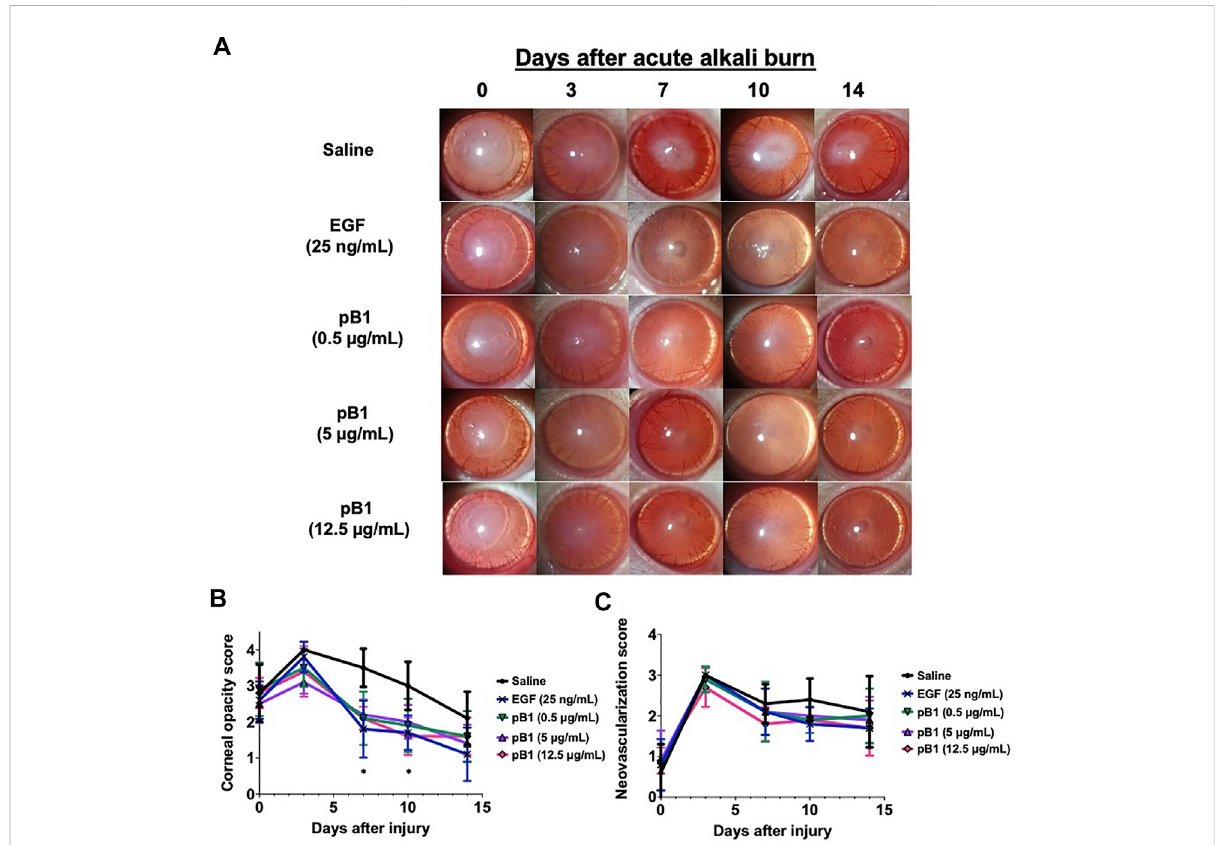
FIGURE 4 Bleogen pB1 reduces corneal opacity in male Wistar rats after a burn caused by 1-N NaOH. (A) Representative photographs of the wound area on days 0, 3, 7, 10, and 14 after the induction of the injury in all corneal injury groups. Five corneal injury groups: (1) saline control (10 rats), (2) EGF (25 ng/ml; 10 rats), (3) pB1 (0.5 μ g/ml; 10 rats), (4) pB1 (5 μ g/ml; 10 rats), and (5) pB1 (12.5 μ g/ml; 10 rats). (B) Bar charts showing the corneal opacity scoreindifferentgroups. (C)